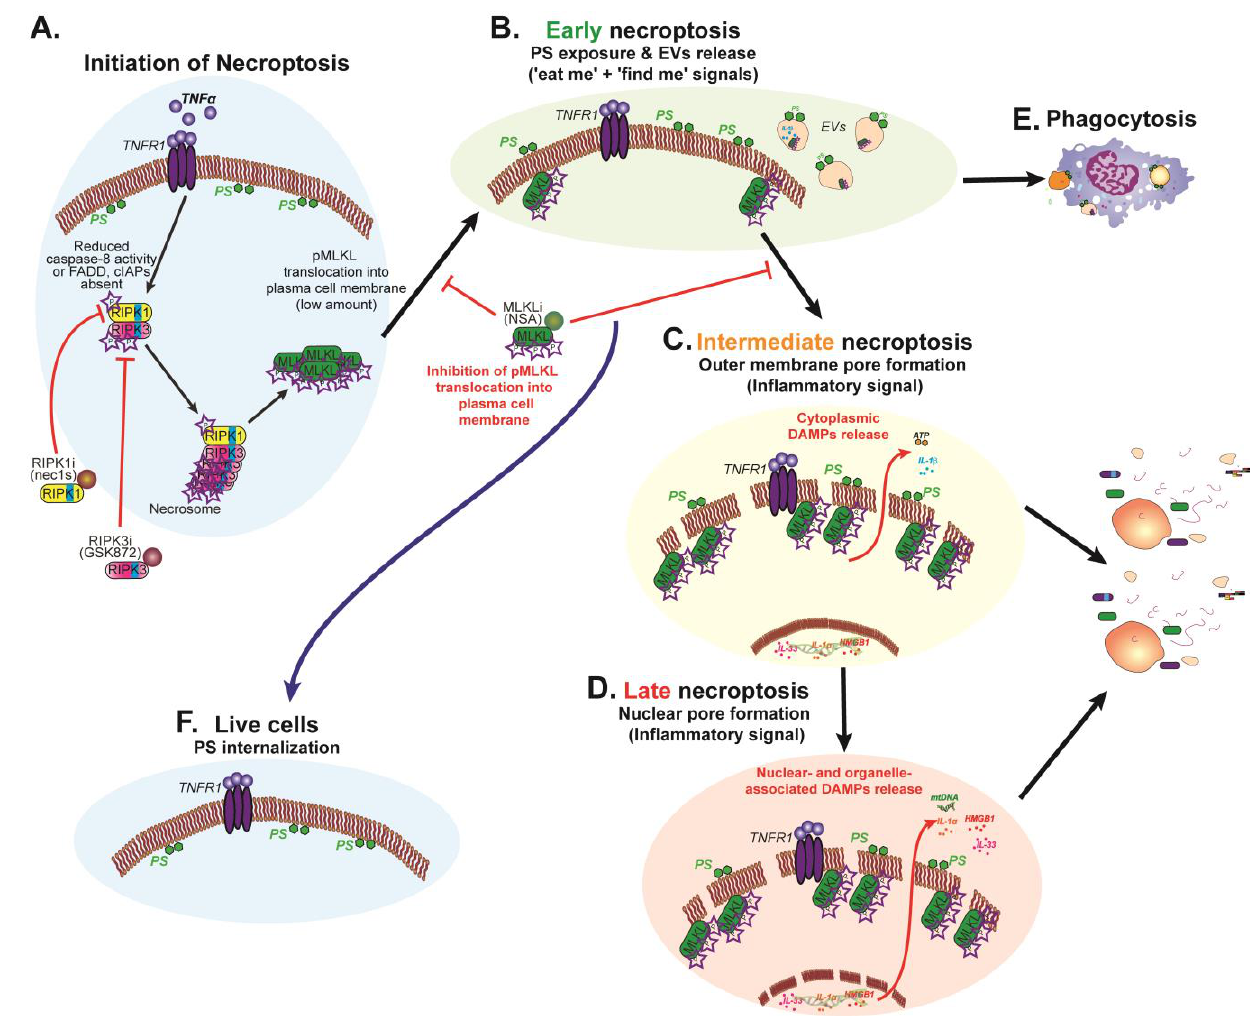
FIGURE 2: The three waves of immunomodulatory processes during necroptosis. Schematic summary and modelling of our results showing the three immunomodulatory waves during necroptosis. (A) Initiation of necroptotic signal transduction results in MLKL phosphorylation, triggering the first immunomodulatory signal (B) as phosphatidylserine (PS) is exposed on the outer membrane and ‘necroptotic bodies’ are released. (C) A second wave occurs when outer membrane integrity is compromised due to MLKL pore formation resulting in cytoplasmic DAMPs release. (D) The last wave of necroptotic immunomodulatory signal occurs when nuclear and organelle membrane integrity are lost leading to release of their DAMPs. (E) Phagocytosis of cells externalizing PS or ‘necroptotic bodies’ containing immunomodulatory intracellu- lar factors. (F) MLKL inhibition can result in rescue of necroptotic cells in the early stages of